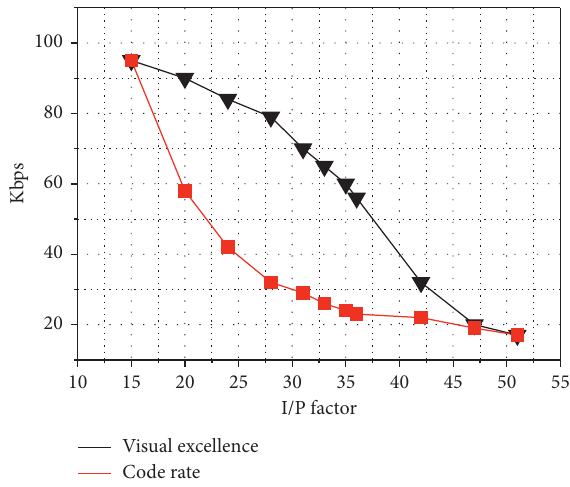
Figure 3: Relationship between I/P factor and visual